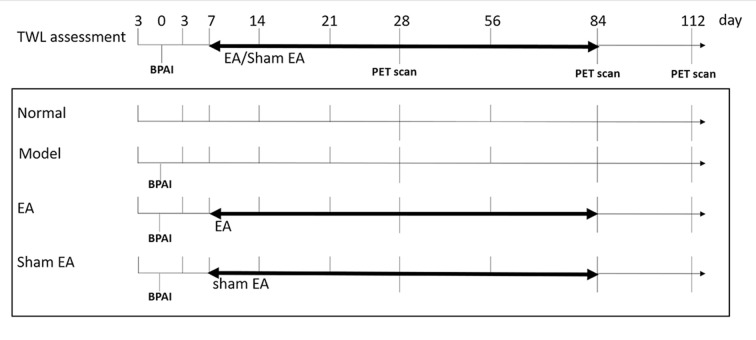
Flow chart of whole experiment. Right side brachial plexus avulsion injury (BPAI) was made on day 0. TWL assessment was conducted on 3rd day before BPAI and 3th, 7th, 14th, 21th, 28th, 56th, 84th, and 112th day following BPAI, respectively. (18F-FDG) PET/CT scan was performed on 28th, 84th, and 112th day following BPAI, respectively. EA/sham EA intervention was performed from 7th to 84th day, which lasted for 11 weeks. BPAI, brachial plexus avulsion; TWL, thermal withdrawal latency; EA, electroacupuncture.